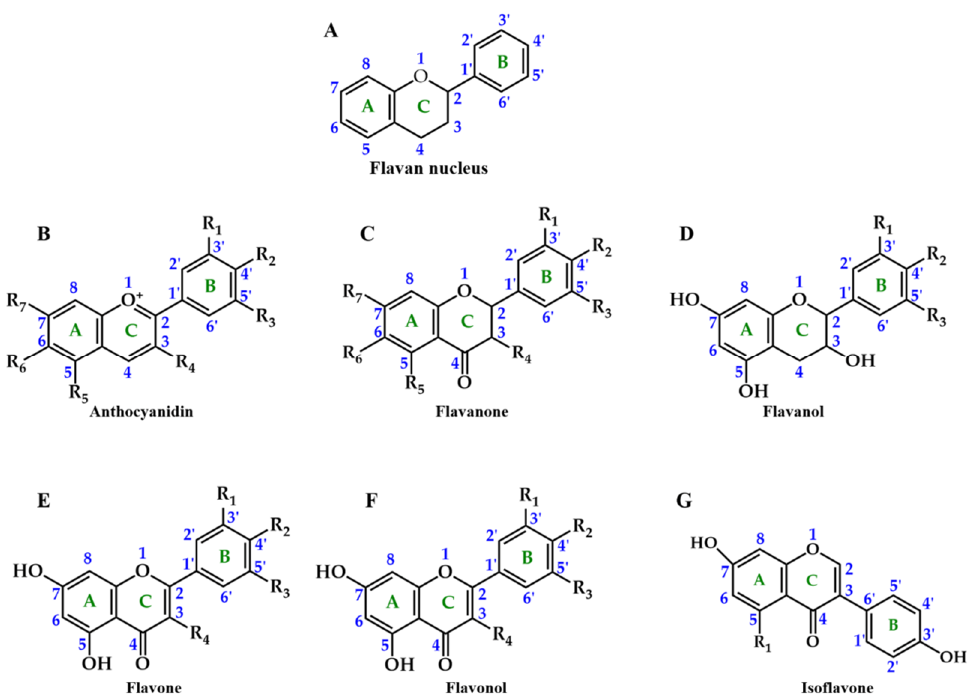
Figure 2. The basic structure of the flavonoids ( A ), which include anthocyanidins (e.g., cyanidin and pelargonidin) ( B ), flavanones (e.g., hesperidin and naringenin) ( C ), flavanols (e.g., catechin and epicatechin) ( D ), flavones (e.g., apigenin and luteolin) ( E ), flavonols (e.g., quercetin and kaempferol) ( F ), and isoflavones (e.g., daidzein and genistein) ( G ), differing in the level of oxidation and C ring saturation (adapted from [31]).